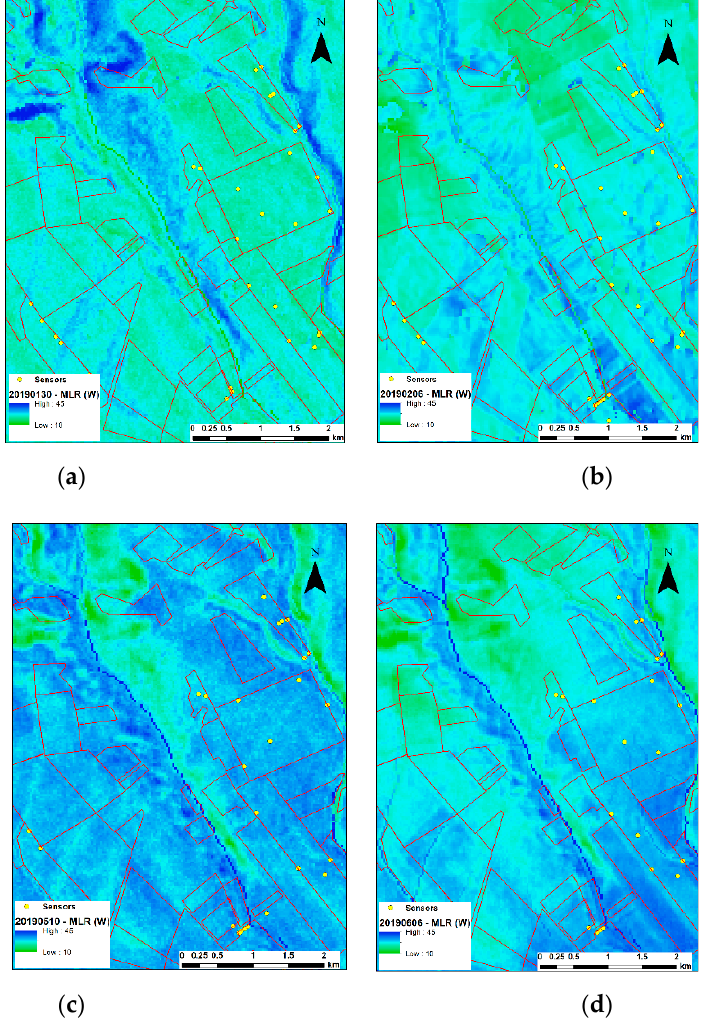
Figure 8. Wheat land use: Predicted soil moisture maps (V%)— ( a ) January 2019, ( b ) February 2019, ( c ) May, and ( d ) June 2019, respectively.